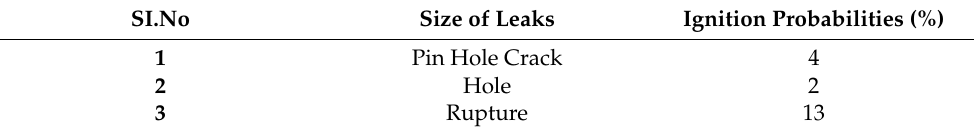
Table 7. Ignition probabilities per leak type.